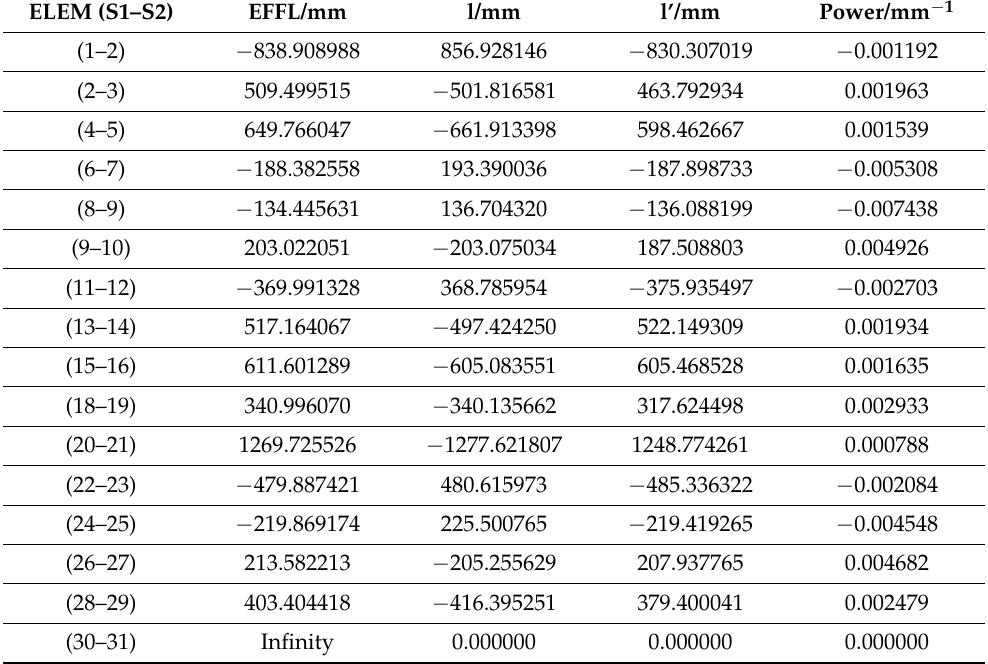
Table 3. Parameters of each lens in patent short focus